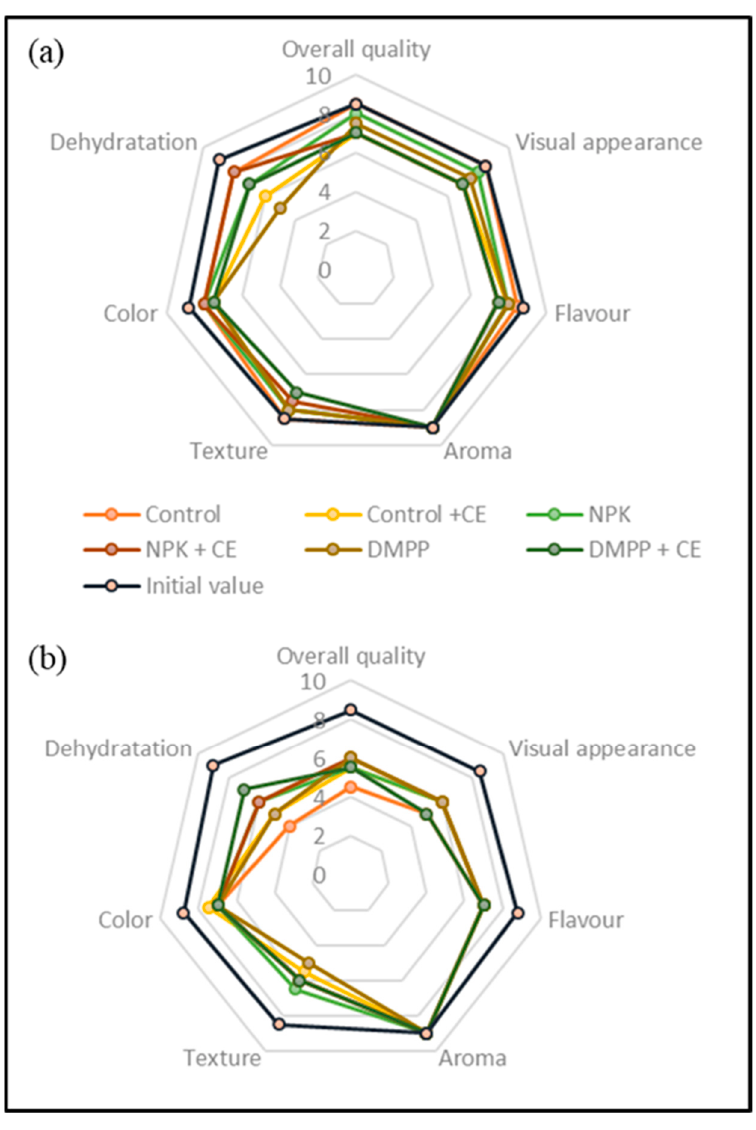
Figure 6. Sensory quality of spinach leaves after ( a ) 6 and ( b ) 12 days of storage at 4 °C. Control; Control + CE, control with compost extract; NPK, inorganic NPK fertilizer 15-15-15; NPK + CE, inorganic NPK with compost extract; DMPP, ENTEC Nitrofoska ® plus the nitrification inhibitor (IN) 3,4-dimethylpyrazole phosphate (DMPP); DMPP + CE, the nitrification inhibitor (IN) with compost extract.